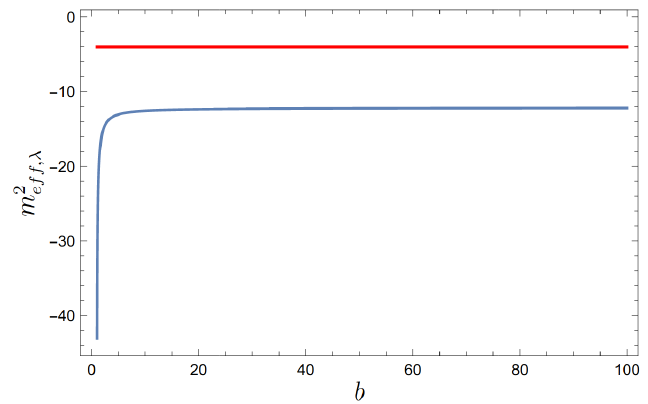
Figure 8 . Effective mass of the λ -scalar evaluated at the Schwarzschild horizon (blue curve), see (3.61). The red line represents AdS